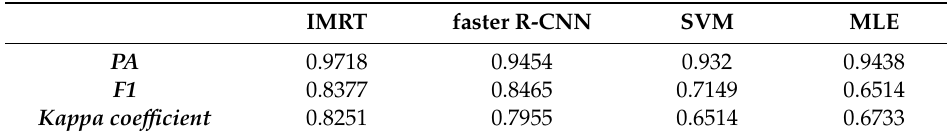
Table 1. Precision evaluation based on pixels.